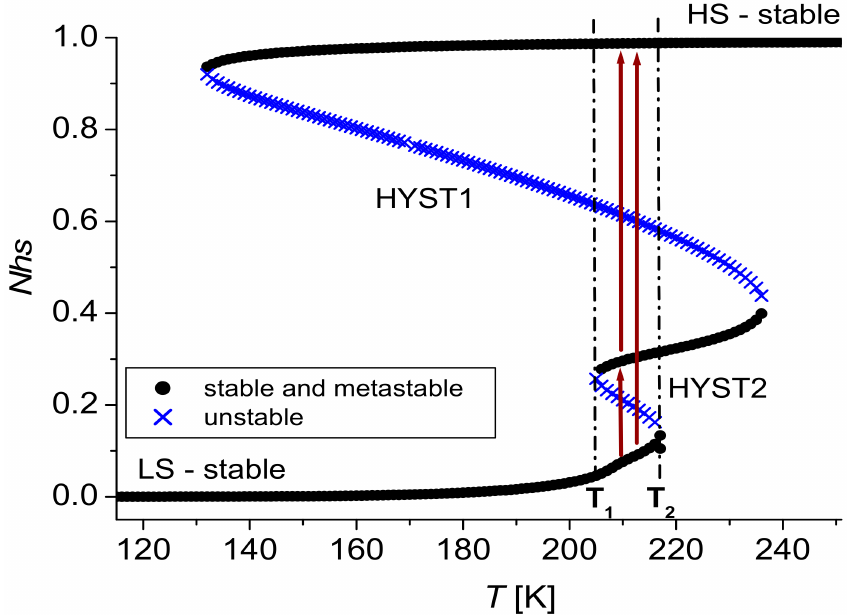
Figure 6. Thermal evolution of the HS molar fraction showing three-state behavior in a 2D hexagonal- shaped system comprising 91 atoms (H6). The computational parameters were ∆ / k B = 1300 K, J / k B = 57 K, G / k B = 150 K, L / k B = 52 K, and ln( g ) =